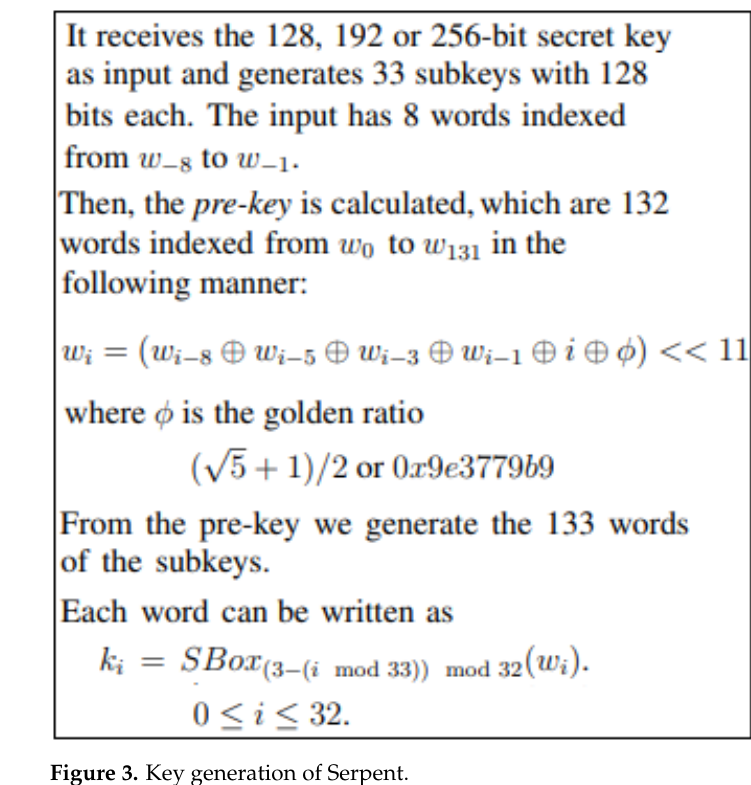
Figure 3. Key generation of